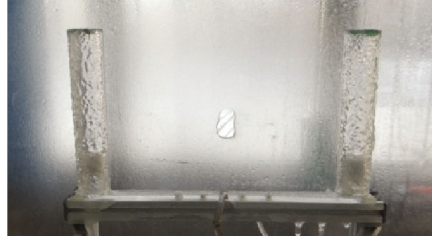
Figure 10: Cylinder sample for calibration.